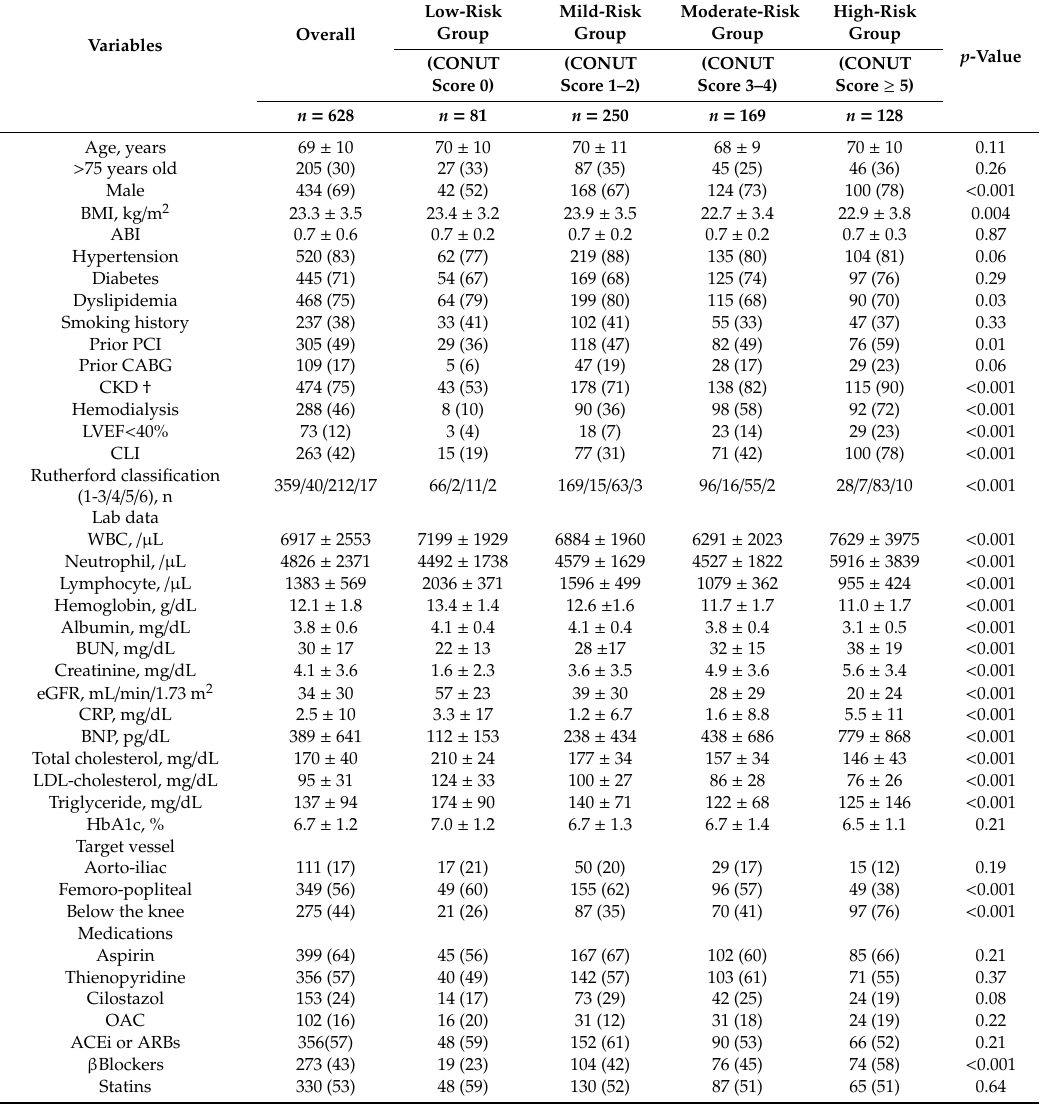
Table 1. Patients’ baseline